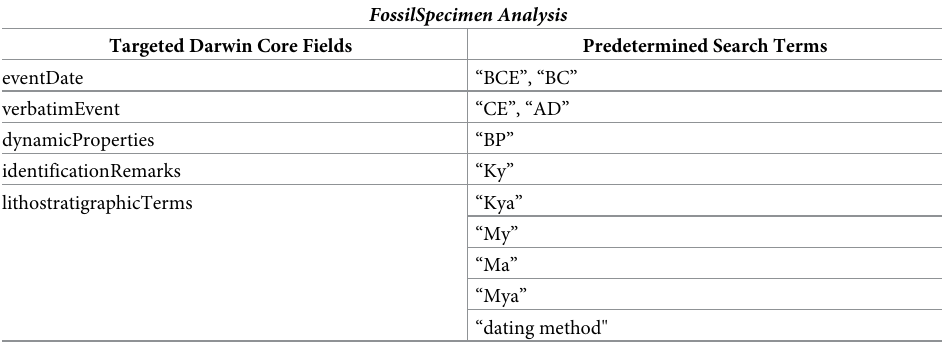
Table 1. A summary of the key fields and search terms for locating chronometry content. The first column shows the targeted fields within Darwin Core where chronometric data may be reported by providers. The second column provides a list of commonly used terms that are often used when reporting chronometry